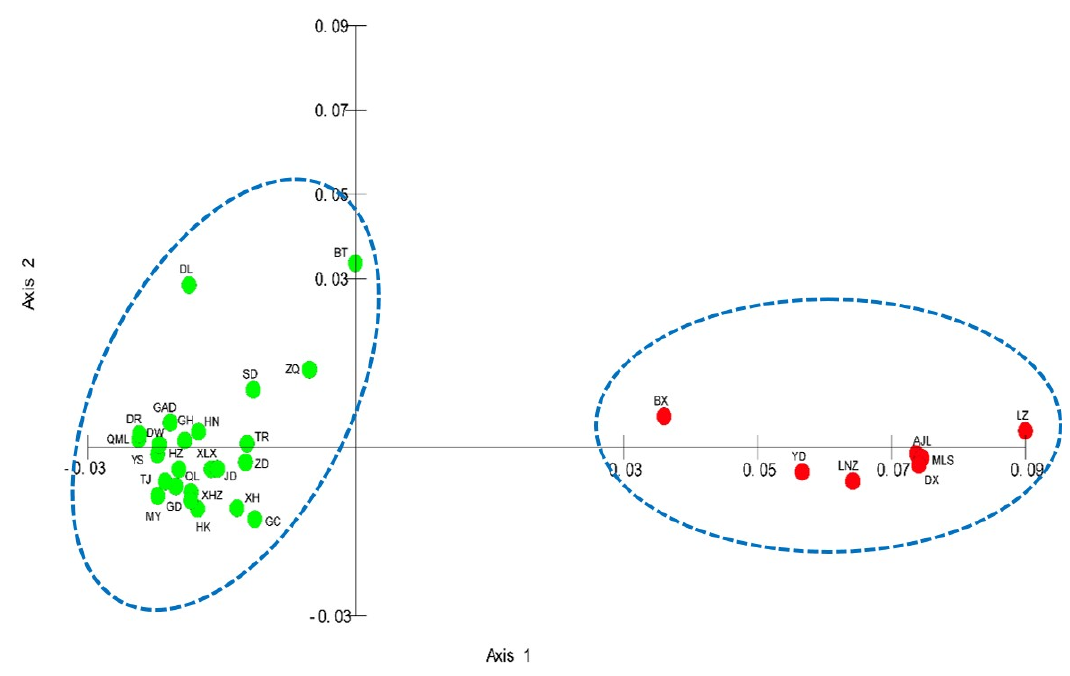
Figure 3. Results of principal coordinates analysis.